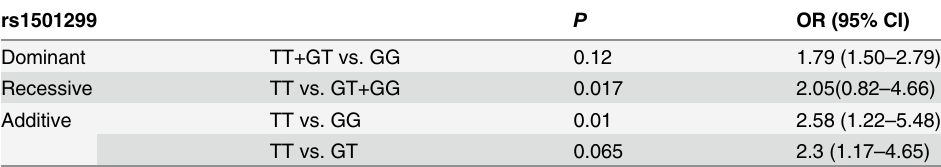
Table 7. Logistic regression analysis of rs1501299.